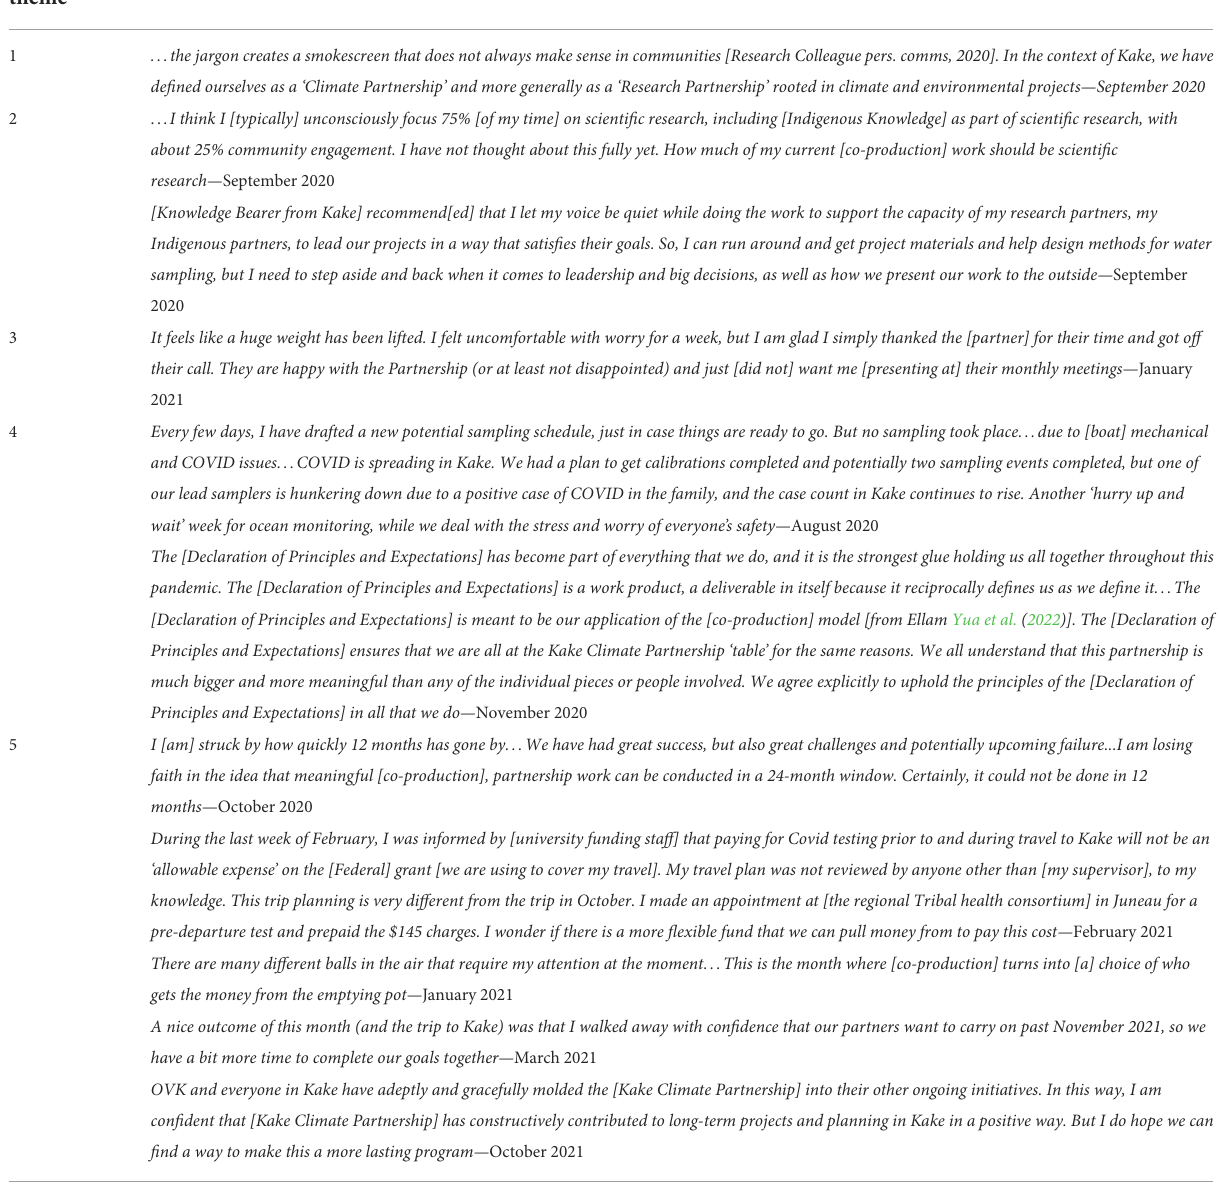
TABLE 7 Example quotes from the monthly logs across the five themes that emerged from the ‘Flex-Pivot’ inductive code. Examples of the ‘Flex-Pivot’ code across five themes